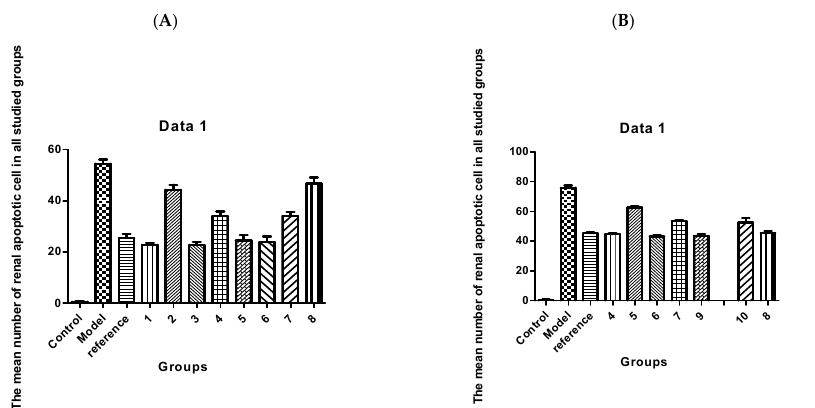
Figure 14. Histogram showing the mean number of ( A ) renal apoptotic cells in all studied groups; and ( B ) supra renal apoptotic cells in all studied groups. Results represented by the mean ± SE ( n =